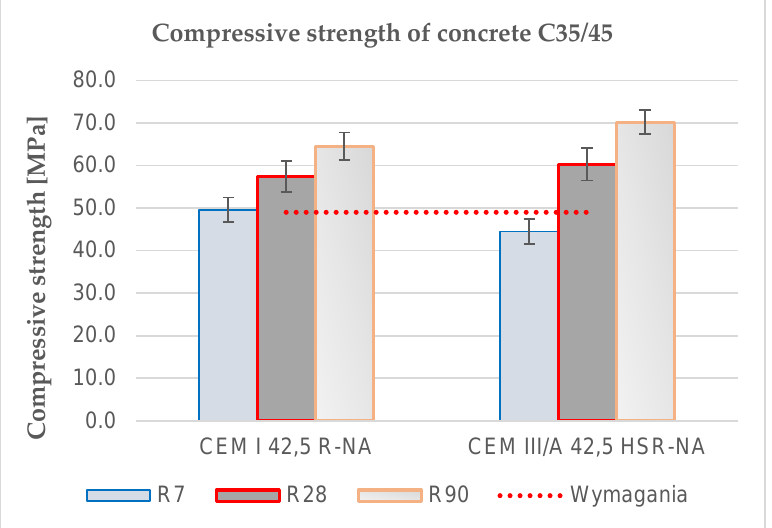
Figure 3. Influence of the type of cement on the determination of the compressive strength of concrete.